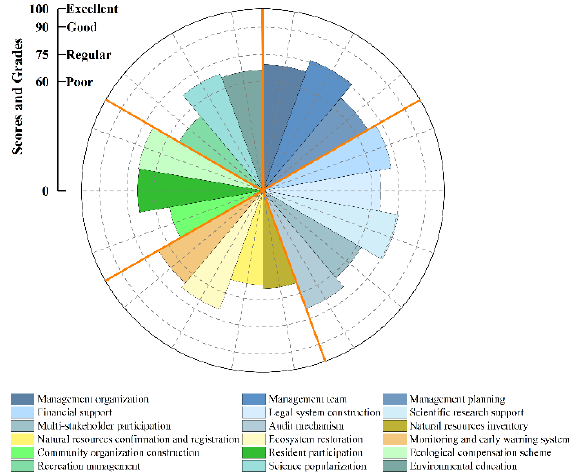
Figure 2. Grades of single management capacity of TNP in 2017.